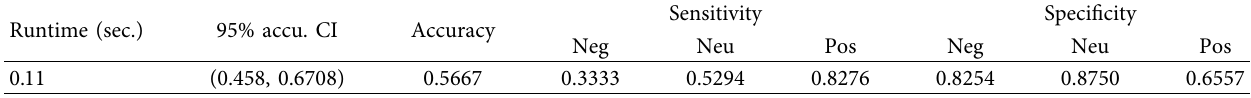
Table 10: Performance statistics of the SVM model.